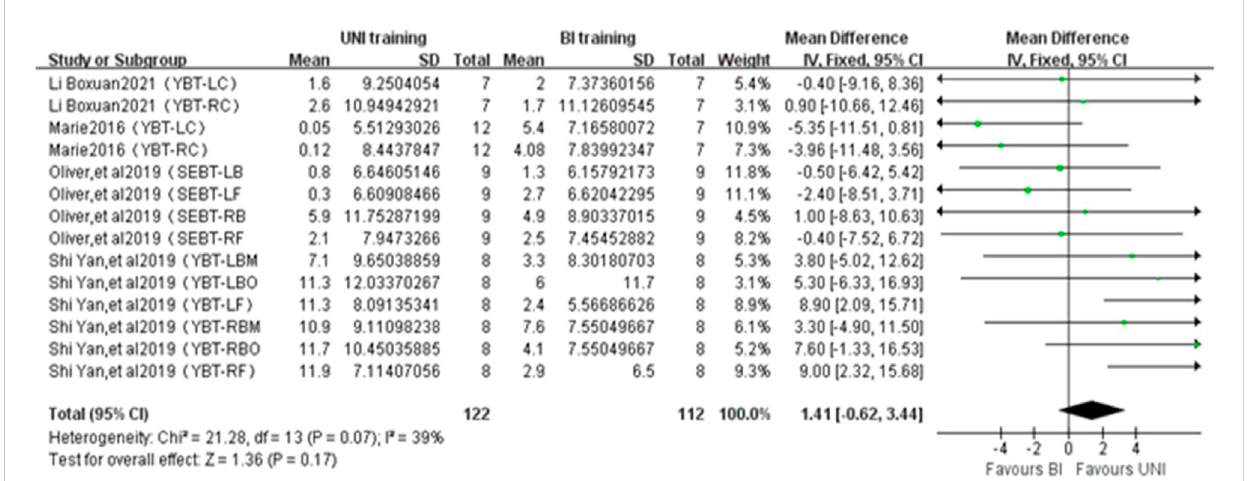
FIGURE 6 IntergroupForest plots of UNIand BItraining affecting BalancePerformance. YBT-LC = Y-Balance testofleft comprehensive; YBT-RC =Y-Balance test of right comprehensive; YBT-LBM = Y-Balance test of left back middle; YBT-LBO = Y-Balance test of left back outer; YBT-LF = Y-Balance test of left front; YBT-RBM = Y-Balance test of right back middle; YBT-RBO = Y-Balance test of right back outer; YBT-RF = Y-Balance test of right front; SEBT-LB